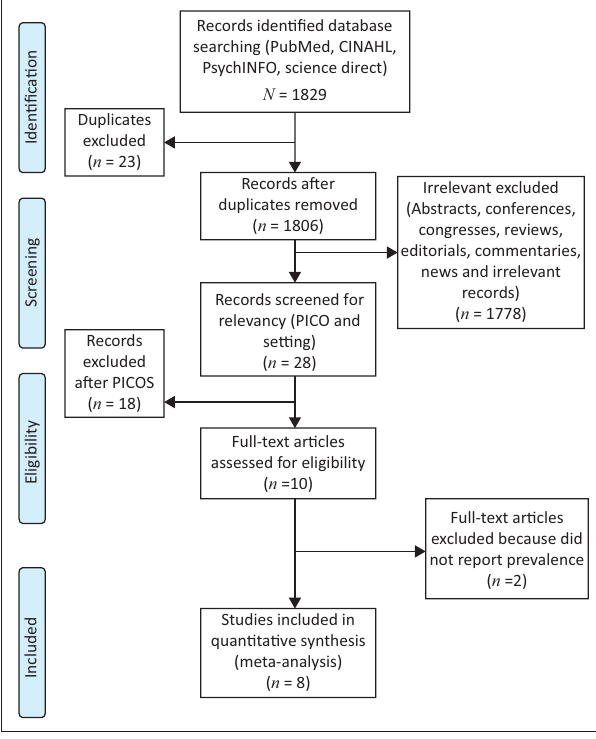
FIGURE 1: Study flow diagram based on Preferred Reporting Items for Systematic Reviews and Meta-Analysis